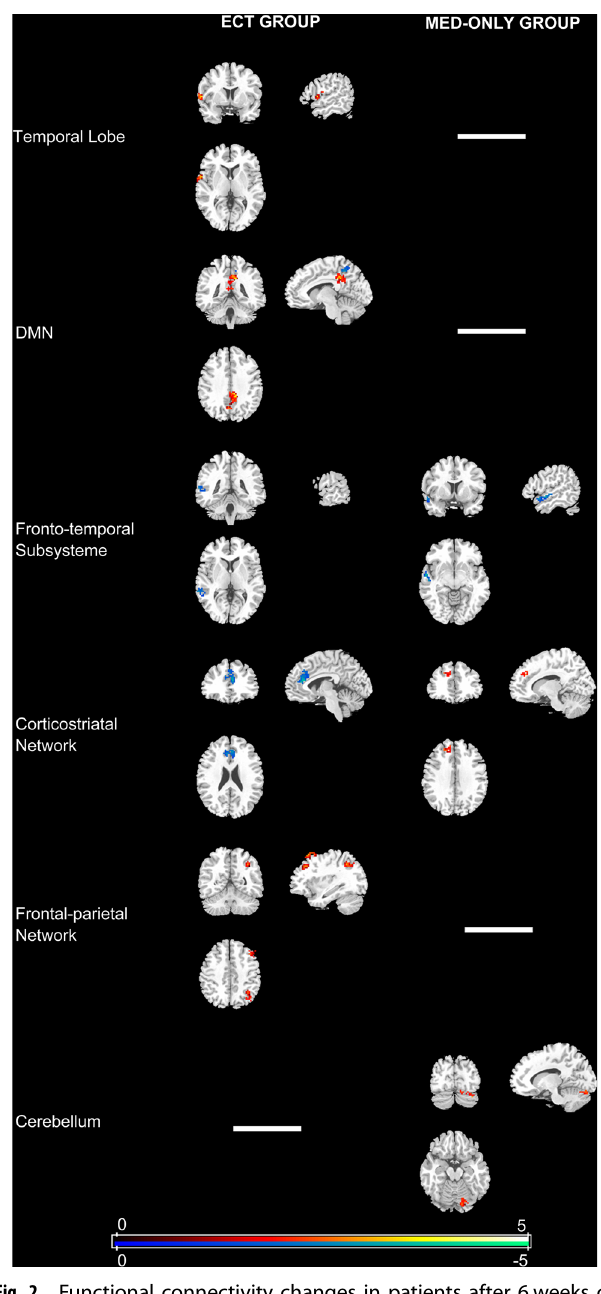
Fig. 2 Functional connectivity changes in patients after 6 weeks of treatment compared with baseline (Pseudo paired t -test based on permutation test, n = 1000, p = 0.05). MED-only group: received antipsychotics only; ECT group: ECT plus antipsychotic